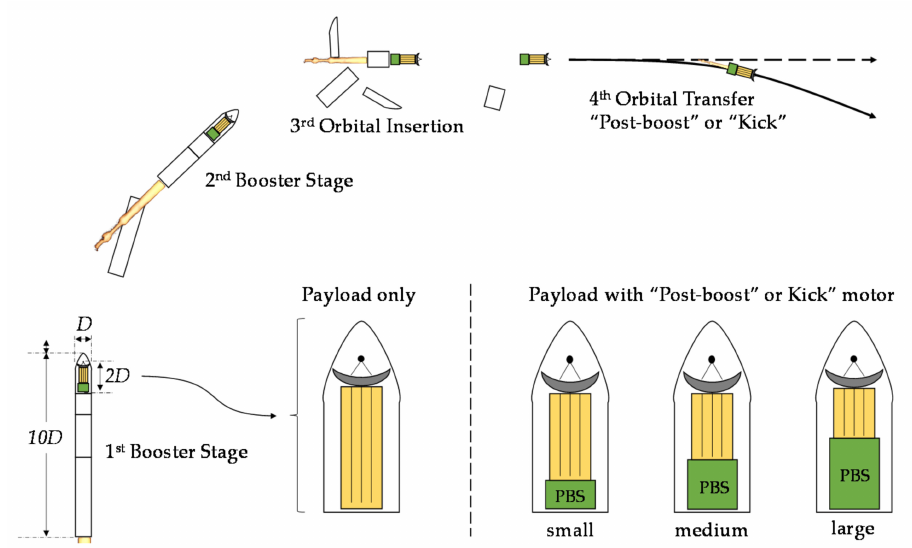
Figure 1. Depiction of post-boost stage and kick motor, and integration into launch